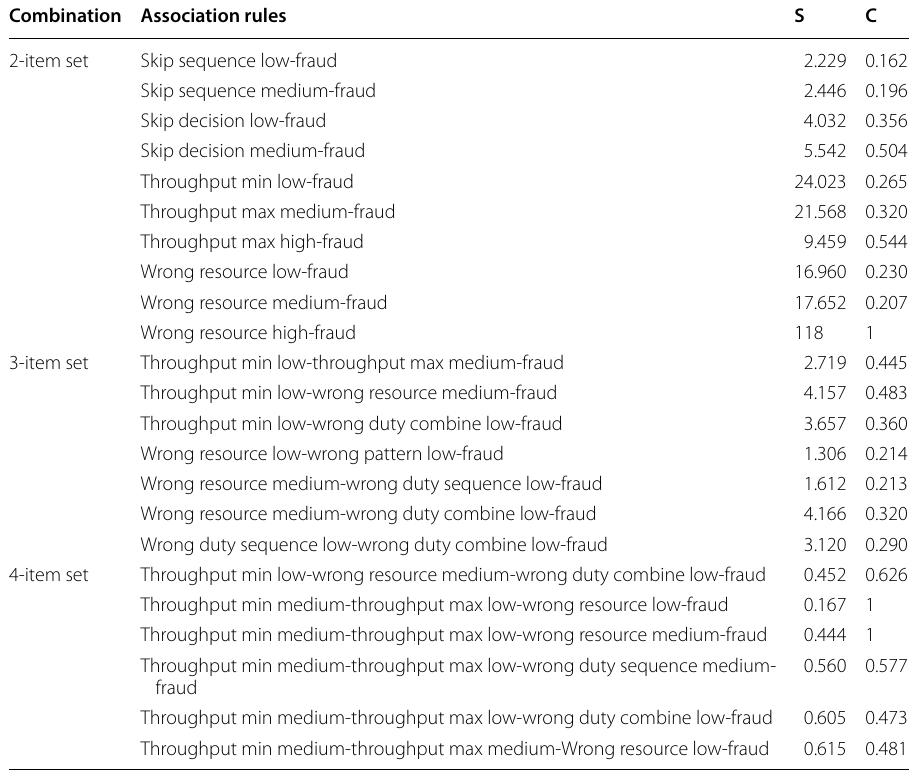
Table 15 Item sets and the corresponding association rules resulted by the fuzzy ARL